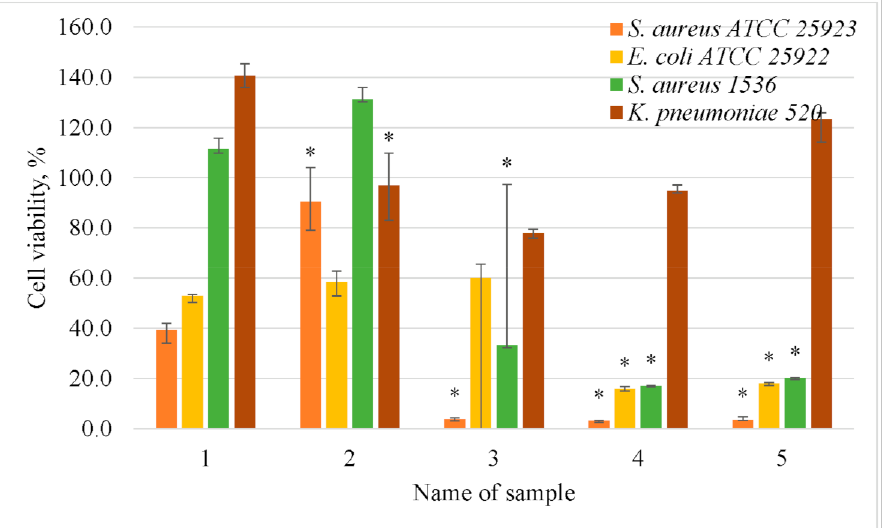
Figure 5. Value of adhered cells after subculturing with yeast extract (crystal violet). The yeast extracts were obtained from samples of yeast S. cerevisiae 71B, cultured in 20% glucose solution with the addition of: (1) sterile dH 2 O, (2) 0.5 mM AgNO 3 , (3) 1.0 mM AgNO 3 , (4) 1.5 mM AgNO 3 and (5) 2.0 mM AgNO 3. * p <